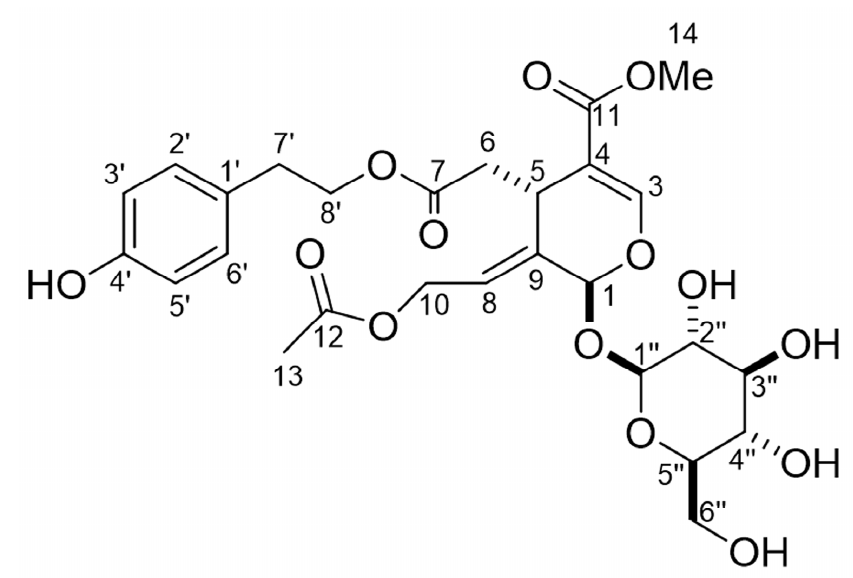
Figure 8. Chemical structure of 10-acetoxyligustroside.